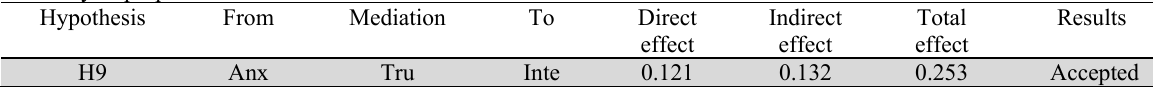
Summary of proposed results for the theoretical model